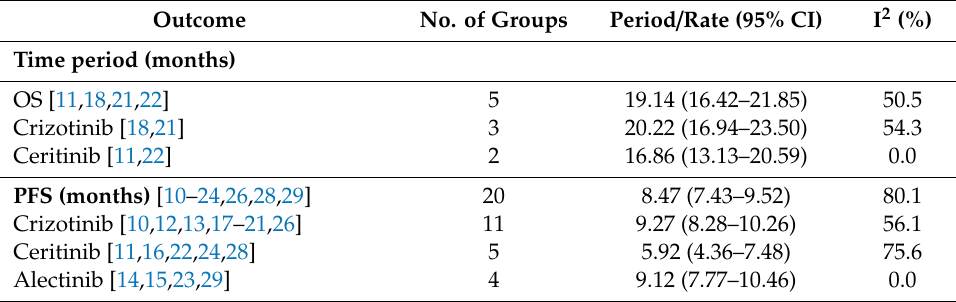
Table 3. Efficacy of ALK inhibitors in patients with ALK-positive non-small cell lung cancer by type of ALK inhibitors for each outcome.